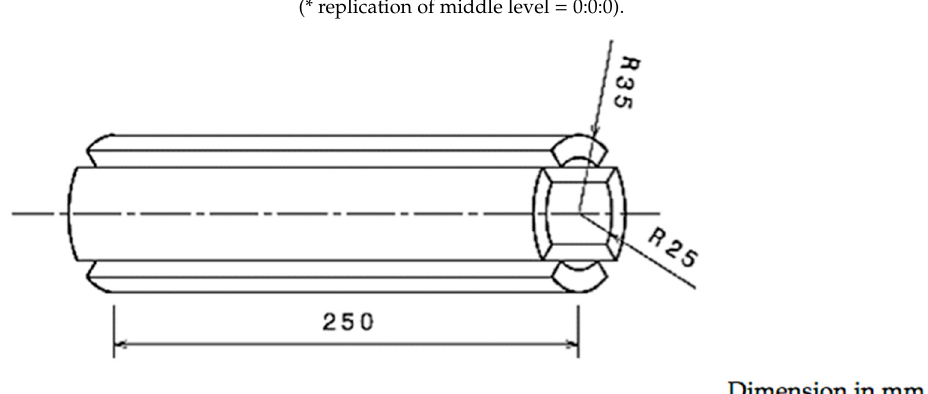
Figure 1. Schematic diagram of the bamboo culm cutting process.